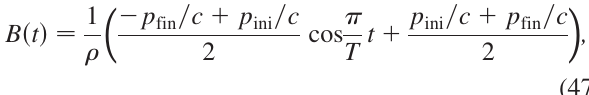
¼ 0 : 61 GeV =c , and the extraction momentum ini